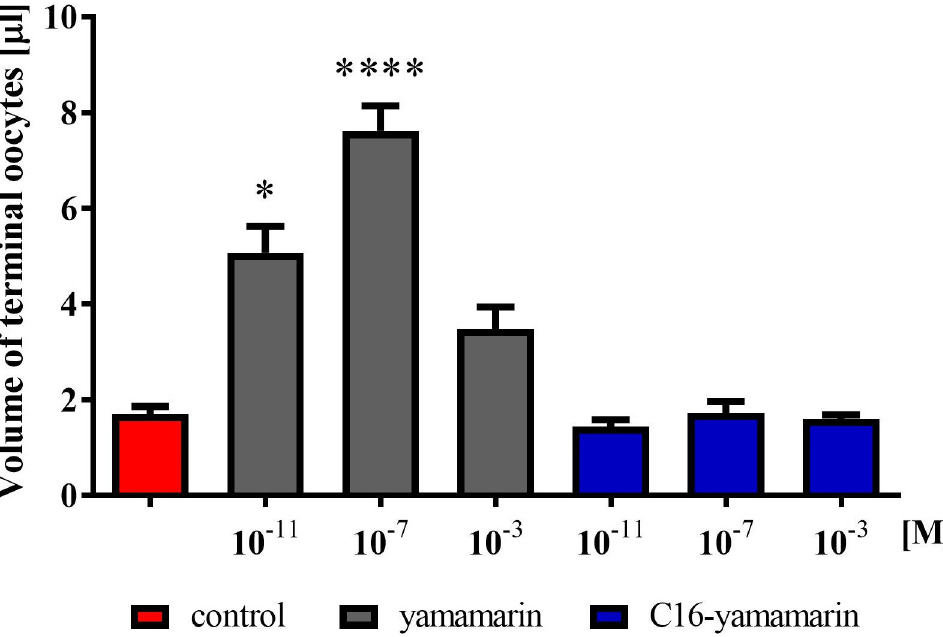
Fig 4. Changes in the volume of the terminal oocytes in the 4-day-old T . molitor females, injected on the first day after eclosion with saline (control), yamamarin, and C16-yamamarin at concentrations 10 − 11 , 10 − 7 and 10 − 3 M. Data represent the mean value ± SD for n � 10. Statistically significant differences (one-way ANOVA, Dunn’s multiple comparisons test) from the control values are indicated by asterisks as indicated: p � 0.0001 ( ���� ), p � 0.1 ( � ).